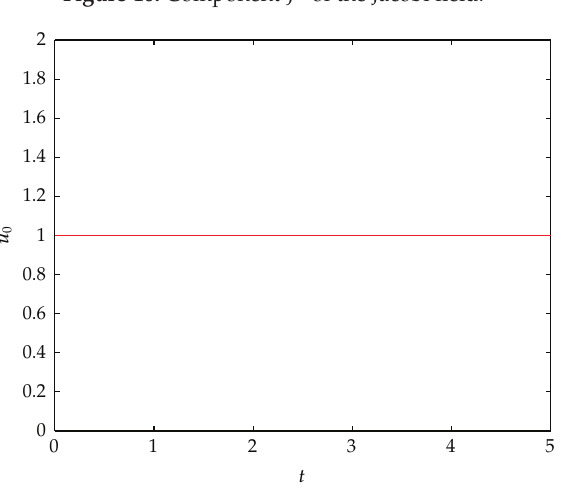
Figure 11: Component u 0